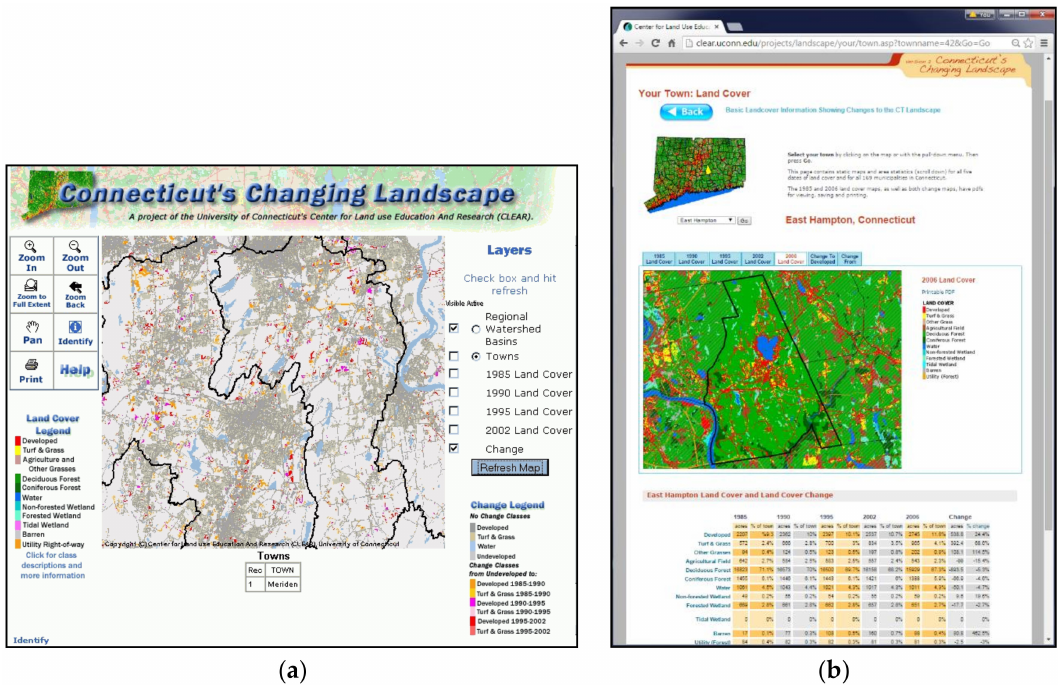
Figure 7. Screen captures from the original (2004) CCL website. ( a ) The original CCL interactive map, showing areas changed to the developed and turf and grass categories from 1985 to 2002—in this example within the context of a regional watershed. ( b ) The Your Town web page, in which viewers could choose their town via the state map or a pulldown menu, and generate a series of maps and a data table detailing land cover change from 1985 to